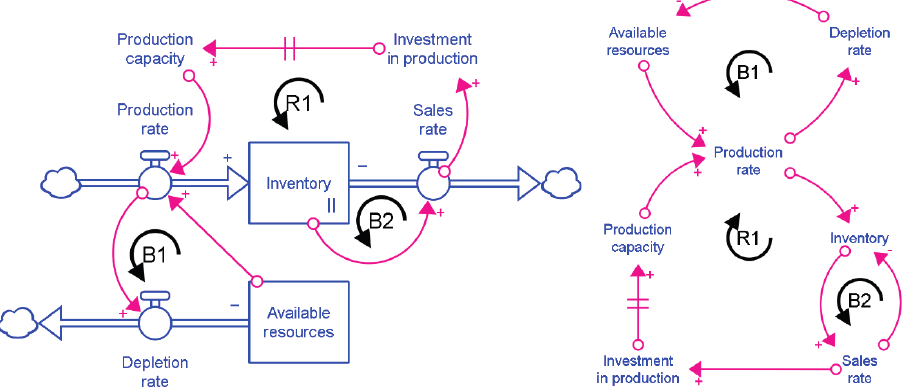
Fig. 1. Example of stock and flow model, and feedback loop